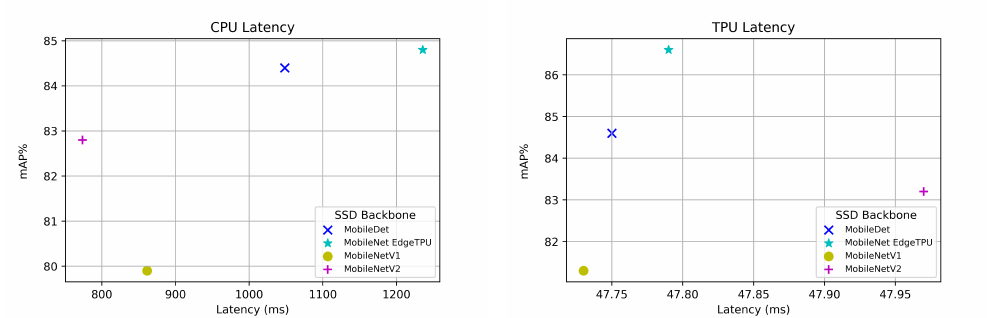
Figure 11. Comparison of mean average precision vs. latency for mobile